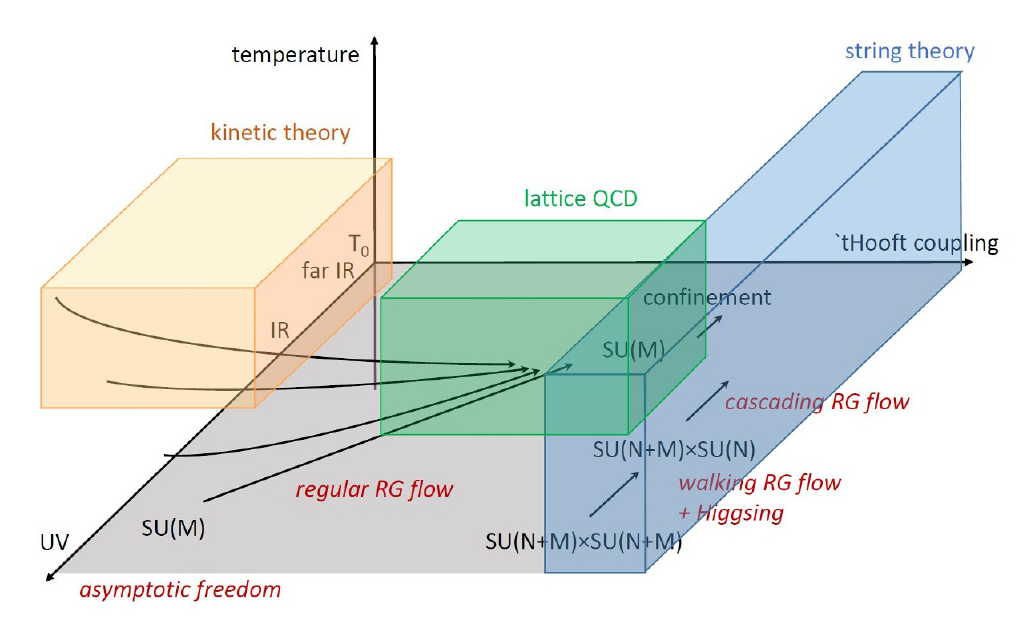
Figure 18 . The three di(cid:11)erent regimes of interest used here to study bulk viscosity. The yellow box denotes the regime of kinetic theory, the green box denotes the regime of LQCD, and the blue box denotes the regime of string theory. All these regimes are analyzed at high temperatures, i.e above the decon(cid:12)nement temperatures, and the regular RG (cid:13)ows connecting the yellow and the green boxes are denoted by black curves. On the other hand, the cascading RG (cid:13)ows, that speci(cid:12)cally arise from string theory, are shown here in the blue box. All the three di(cid:11)erent RG (cid:13)ows lead to a consistent picture at low energies connecting the weak, intermediate and strong ’t Hooft couplings. However the UV pictures are very di(cid:11)erent, for example in the string side, i.e in the blue box, the UV gauge group is a product gauge group and is at strong ’t Hooft